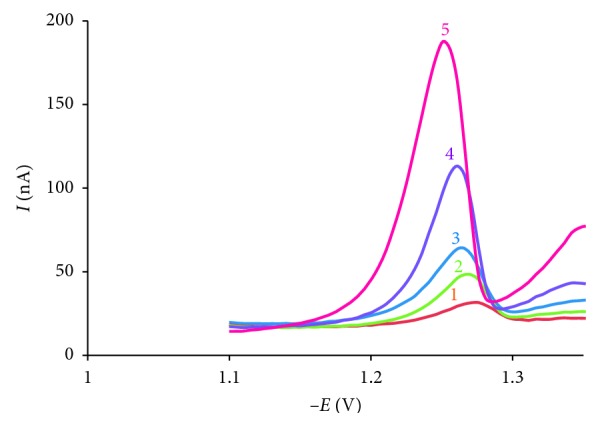
Voltammogram of AO in the range of 10−8 mol·L−1–6.4 × 10−7 mol·L−1 with conditions pH = 9.0, Eacc = −0.5 V, tacc = 60 s, scan rate = 250 mV·s−1, f = 50 Hz. (1) 4.10−8 mol·L−1; (2) 12.10−8 mol·L−1; (3) 20.10−8 mol·L−1; (4) 32.10−8 mol·L−1; (5) 64.10−8 mol·L−1.